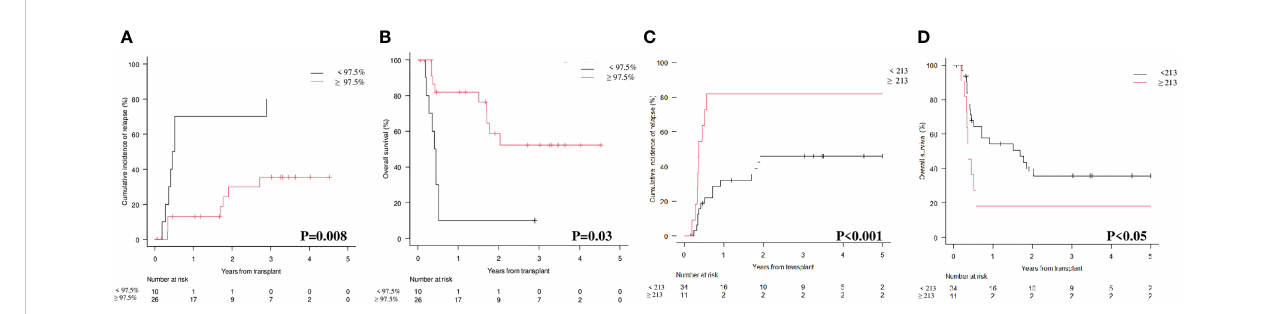
FIGURE 2 Cumulative Incidence of Relapse (CIR) and Overall Survival (OS) according to molecular chimerism on CD34+ cells and WT1 levels at 1st month. (A) CIR at 1 year CD34+ ≥ 97.5% vs <97.5% donor: 13% (95% CI 3.3-29.7) vs 70% (95% CI 32.9.89.2). (B) OS at 1 year CD34+ ≥ 97.5% vs <97.5% donor: 81.8% (95%